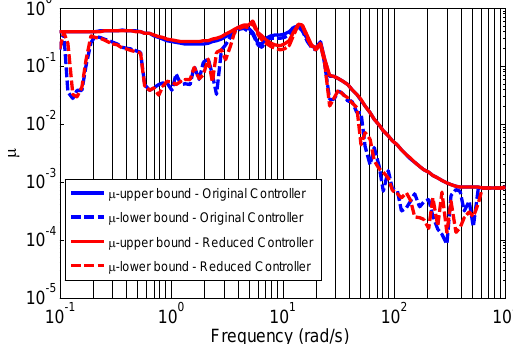
Table 1. Gamma calculations for H controller ∞ Hence, for all possible uncertain plant models G=F U (G WT ,Δ) obtained with ± 20% uncertainty in the system elements the closed loop system performance is achieved (μ<1) by the designed original (14th order) and the reduced (7th order) controllers as shown in figure 7. It means that the system retained its stability for all its values in the range from 80% to 120% of the nominal values.